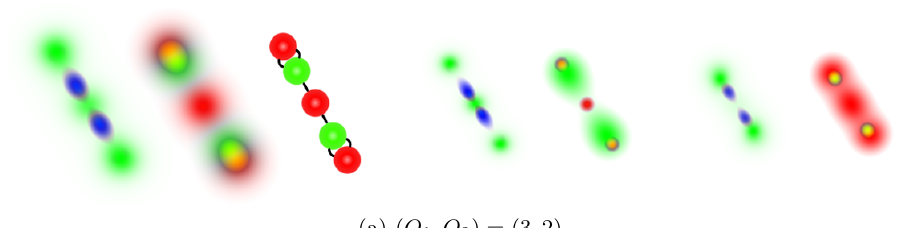
Figure 17 : ( Q 1 ; Q 2 ) = ( Q + 1 ; Q ) vortex \stick", with Q = 2. The (cid:12)gure contains 7 elements from left to right: for column 1 through 3: v 1 =v 2 = 1: an energy density plot, a (cid:12)eld density plot and a sketch of how the red and green vortices are interconnected. For column 4 and 5: v 1 =v 2 = 2: an energy density plot and a (cid:12)eld density plot. For column 6 and 7: v 1 =v 2 = 1 = 2: an energy density plot and a (cid:12)eld density plot. All columns except column 3 are made using the coloring scheme of (cid:12)gure 2.